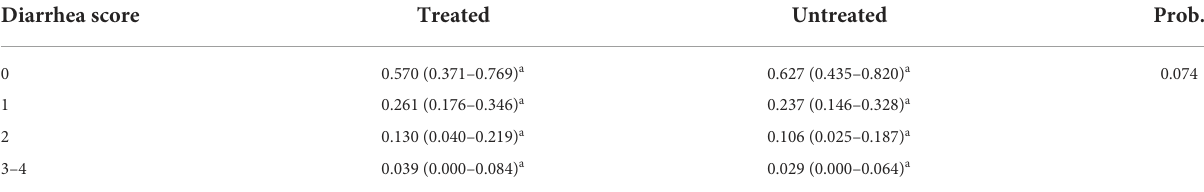
TABLE 6 Diarrhea Score of treated and untreated groups on S1 and S2. Diarrhea score Treated Untreated